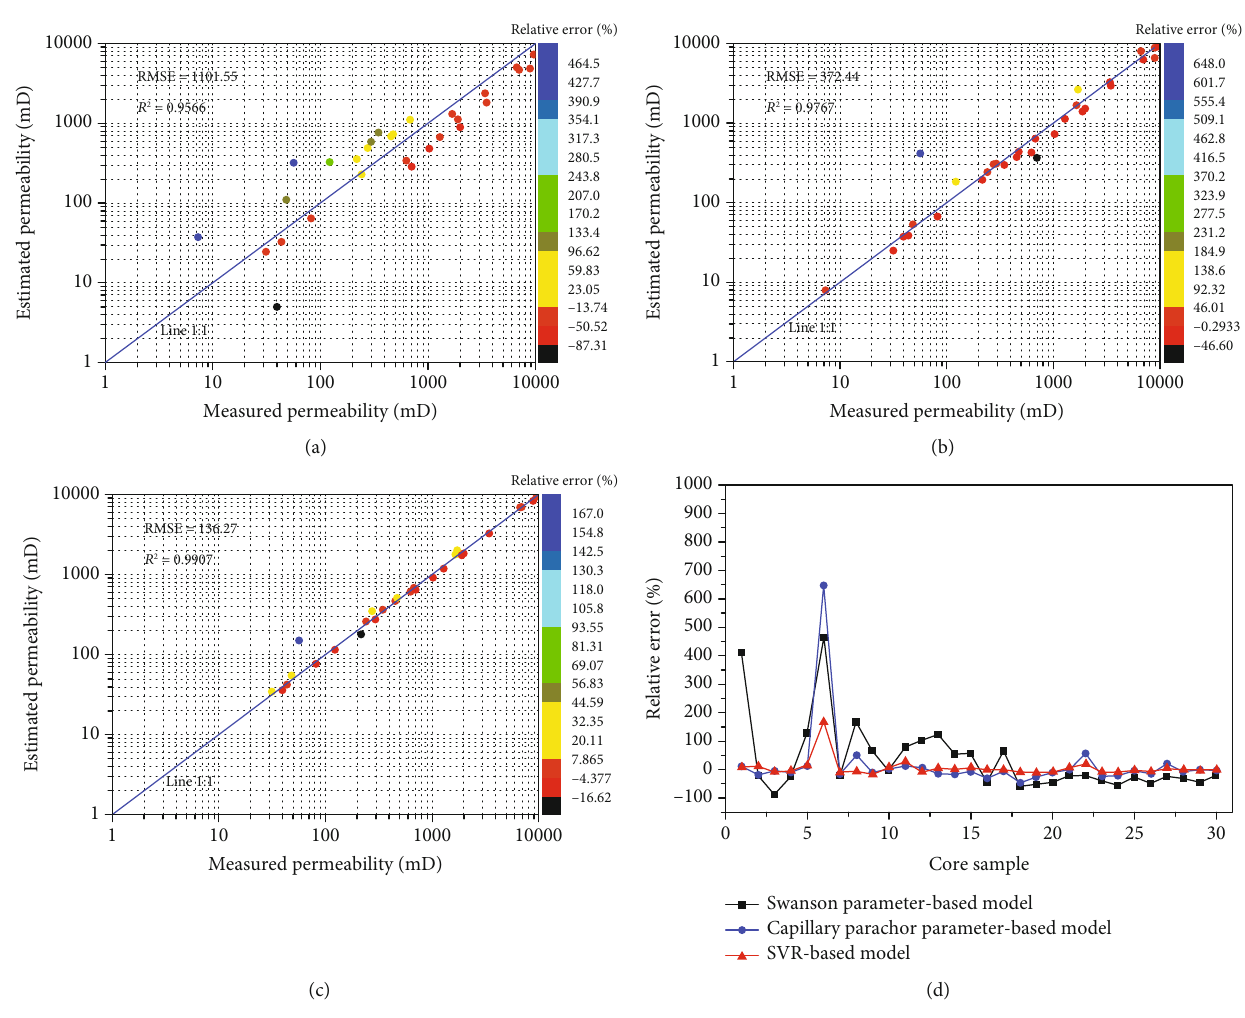
Figure 5: Comparison between the permeability prediction results and assessments of the core specimens: (a) Swanson parameter-based model results; (b) capillary parachor parameter-based model results; (c) SVR model results; (d) relative error of all models. A notable match is indicated by the results between the SVR model predicted and the measured